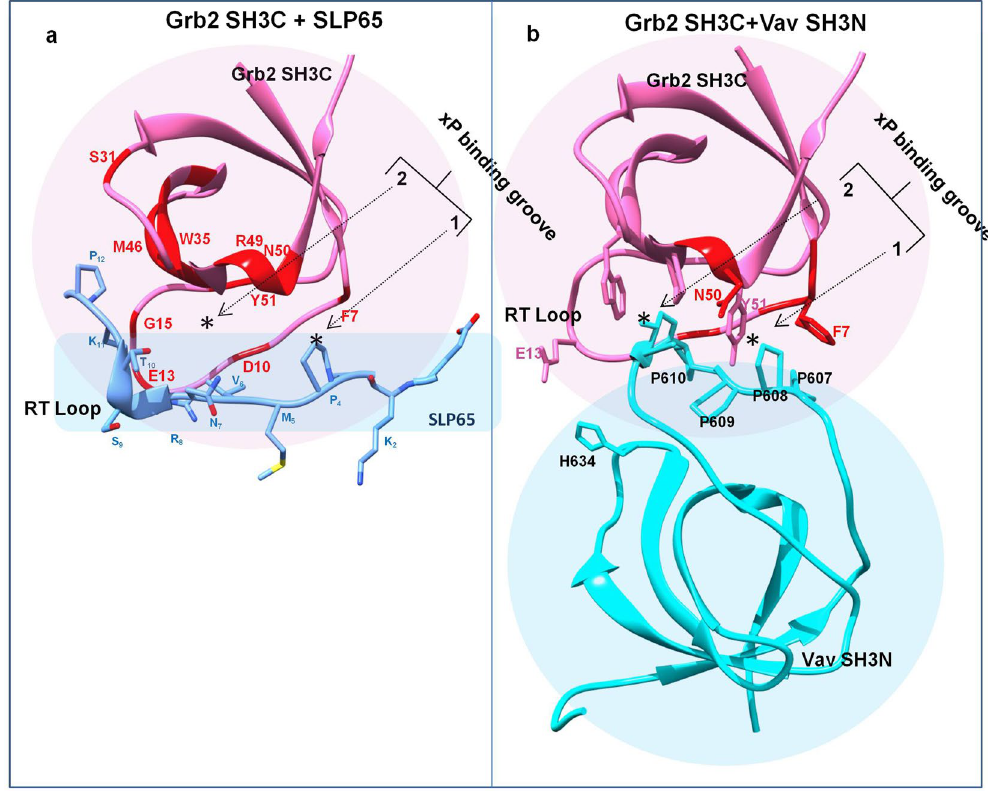
Figure 3. Comparison of the interaction interface of the Grb2 SH3C complexes. A ribbon representation of the ( a ) Grb2 SH3C in complex with SLP65 peptide (based on 2VWF), and ( b ) Grb2 SH3C domain in complex with Vav SH3N domain (1GCQ). The backbone amides that display chemical shift changes in the Grb2 SH3C domain in our studies are highlighted in